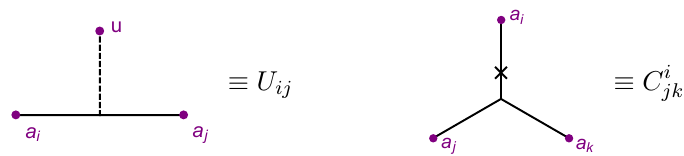
of defect operators. Here the dotted line stands for jk